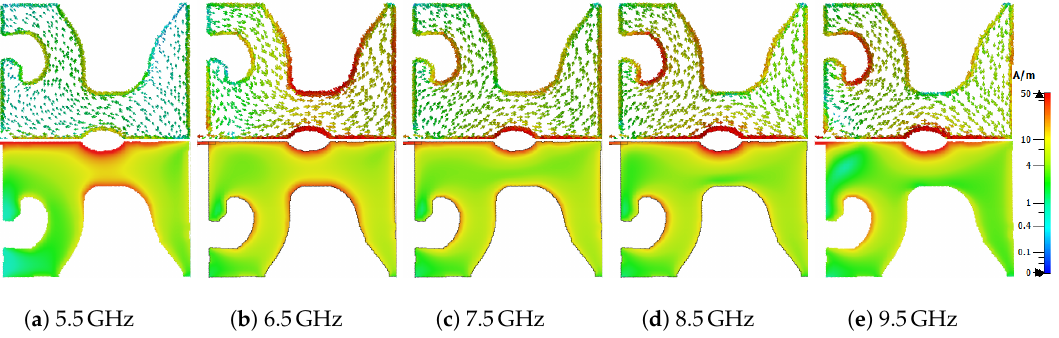
Figure 12. Surface current distribution on Antenna III.